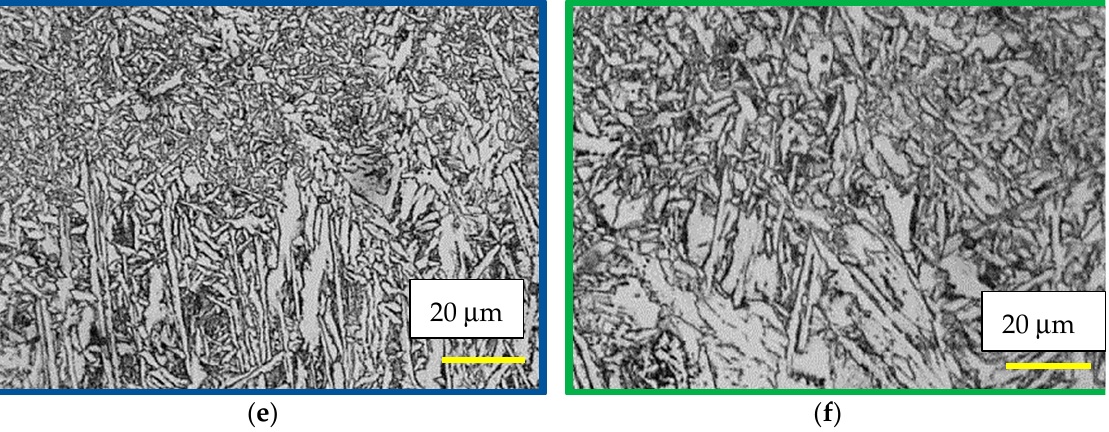
Figure 4. Microstructure of welds made with various process speeds (welding with micro-jet cooling), observation at different magnifications, ( a – c ) specimen Sa1 (300 mm/min), LM ( d – f ) specimen Sa5 (450 mm/min), and LM (W—weld material, HAZ).